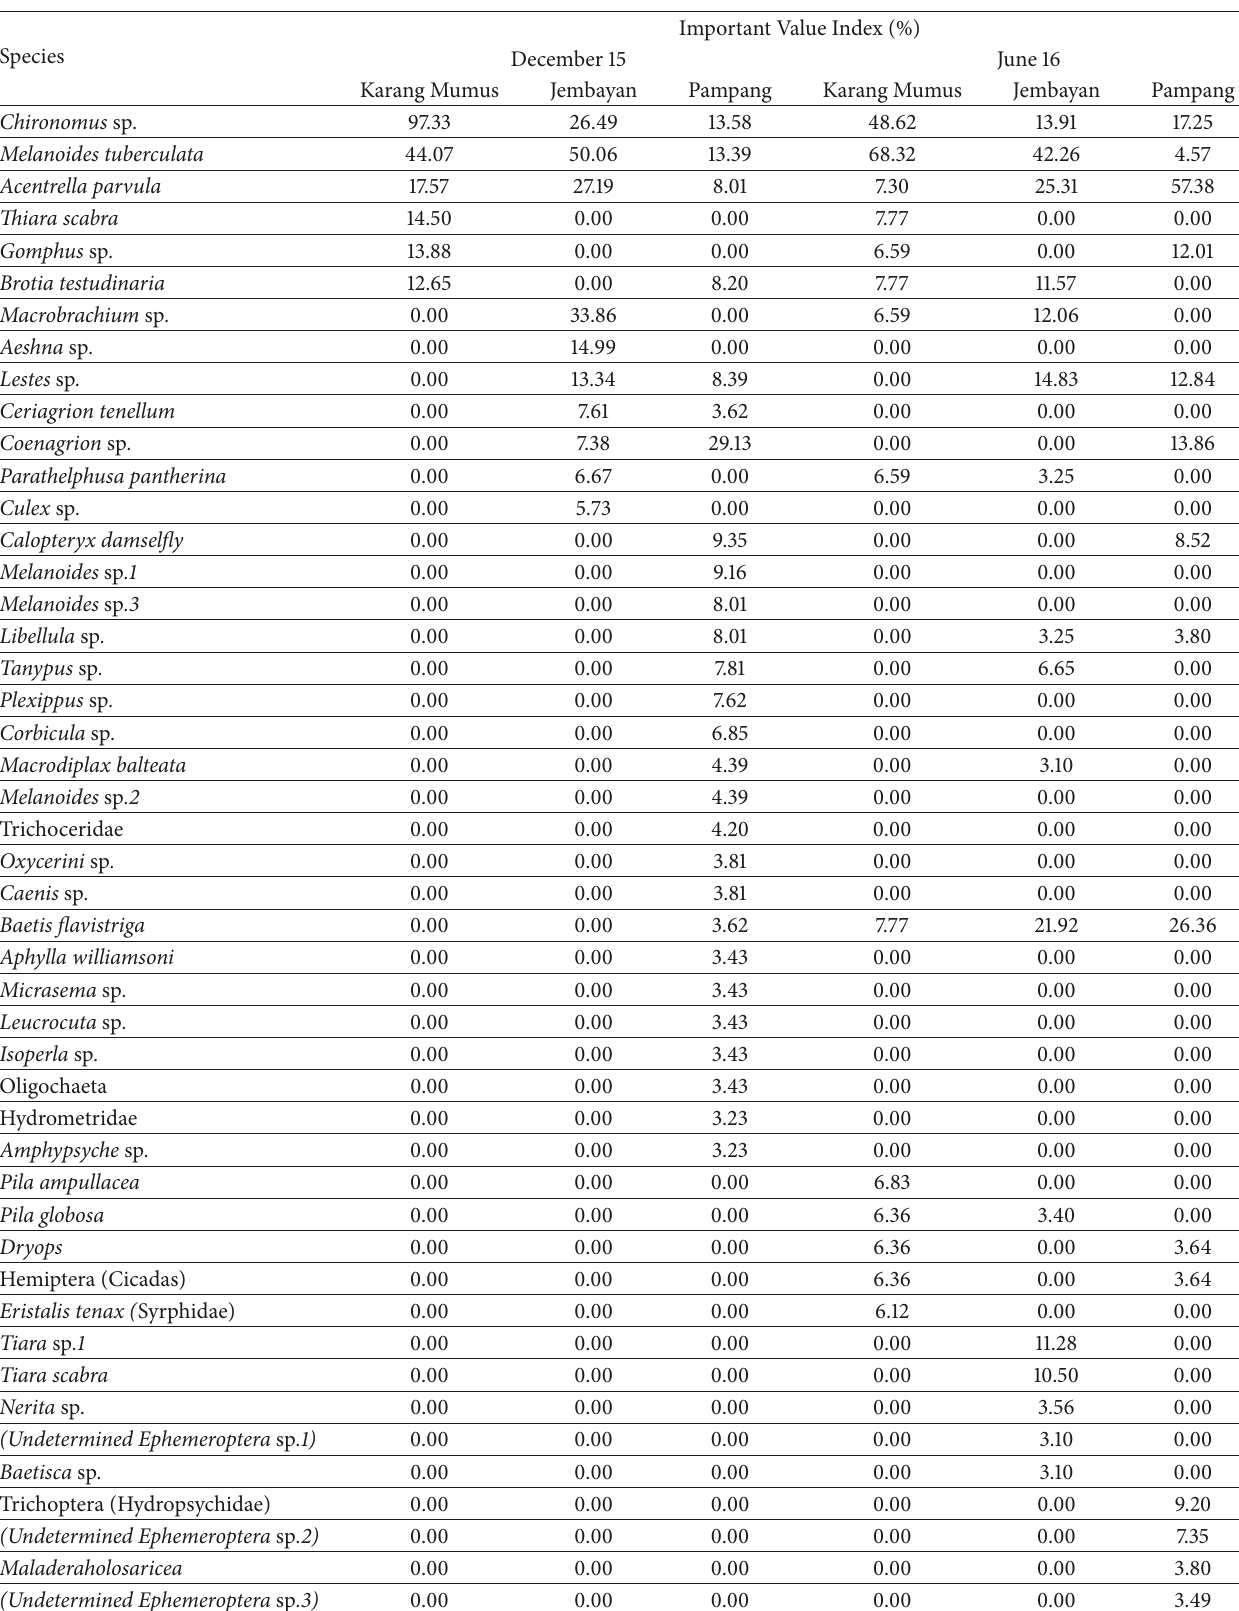
Table 3: Important value index (IVI) of benthic